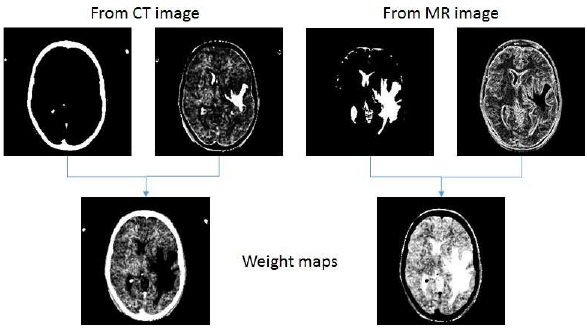
Figure 4. Stage of obtaining weight maps